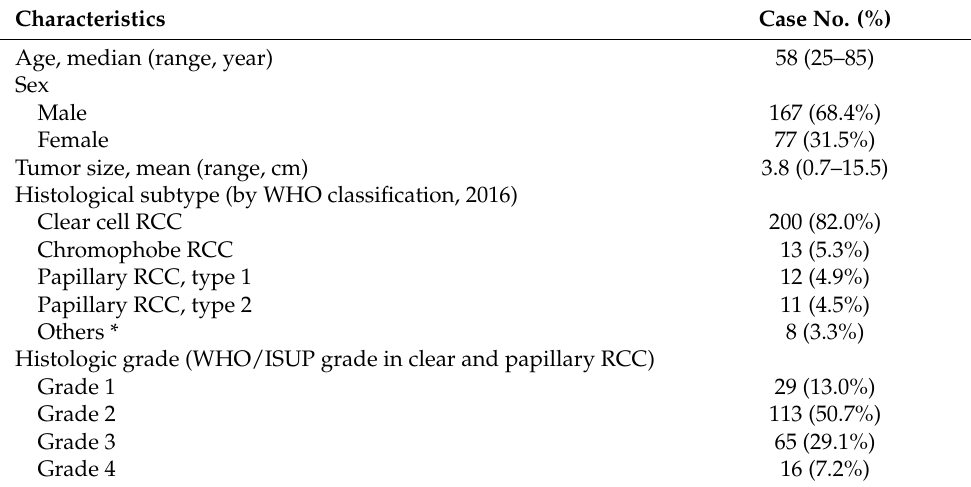
Table 1. Baseline clinicopathological characteristics of RCC